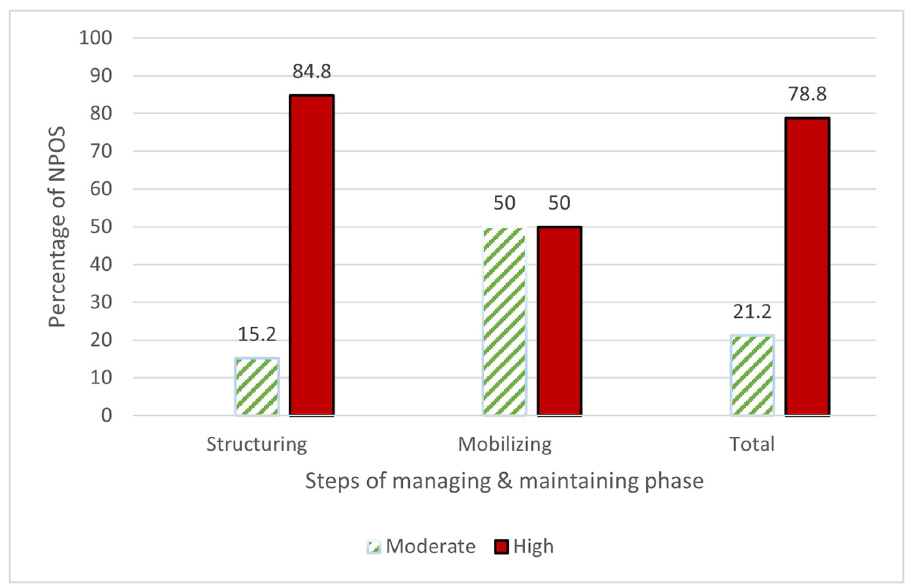
Fig 3. Nonprofit organizations’ implementation level of managing and maintaining steps.